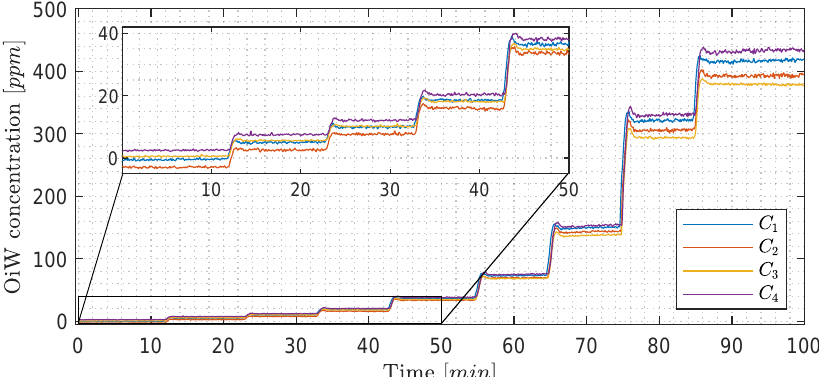
Figure 15. A 100 min experiment with eight different OiW concentrations as in Figure 13. The measurements from the four OiW monitors are displayed in ppm based on the OLS calibration